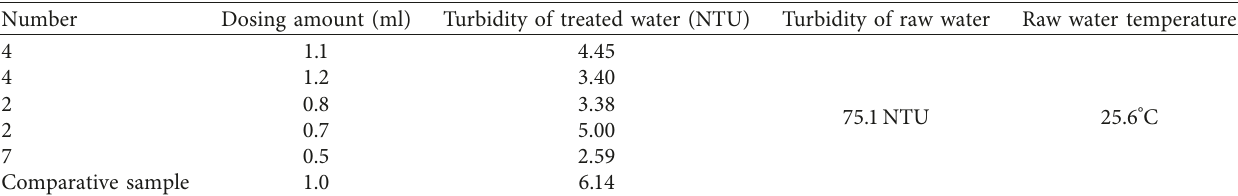
Table 11: Comparison experiment of formula nos. 2, 4, and 7 and contrast sample.